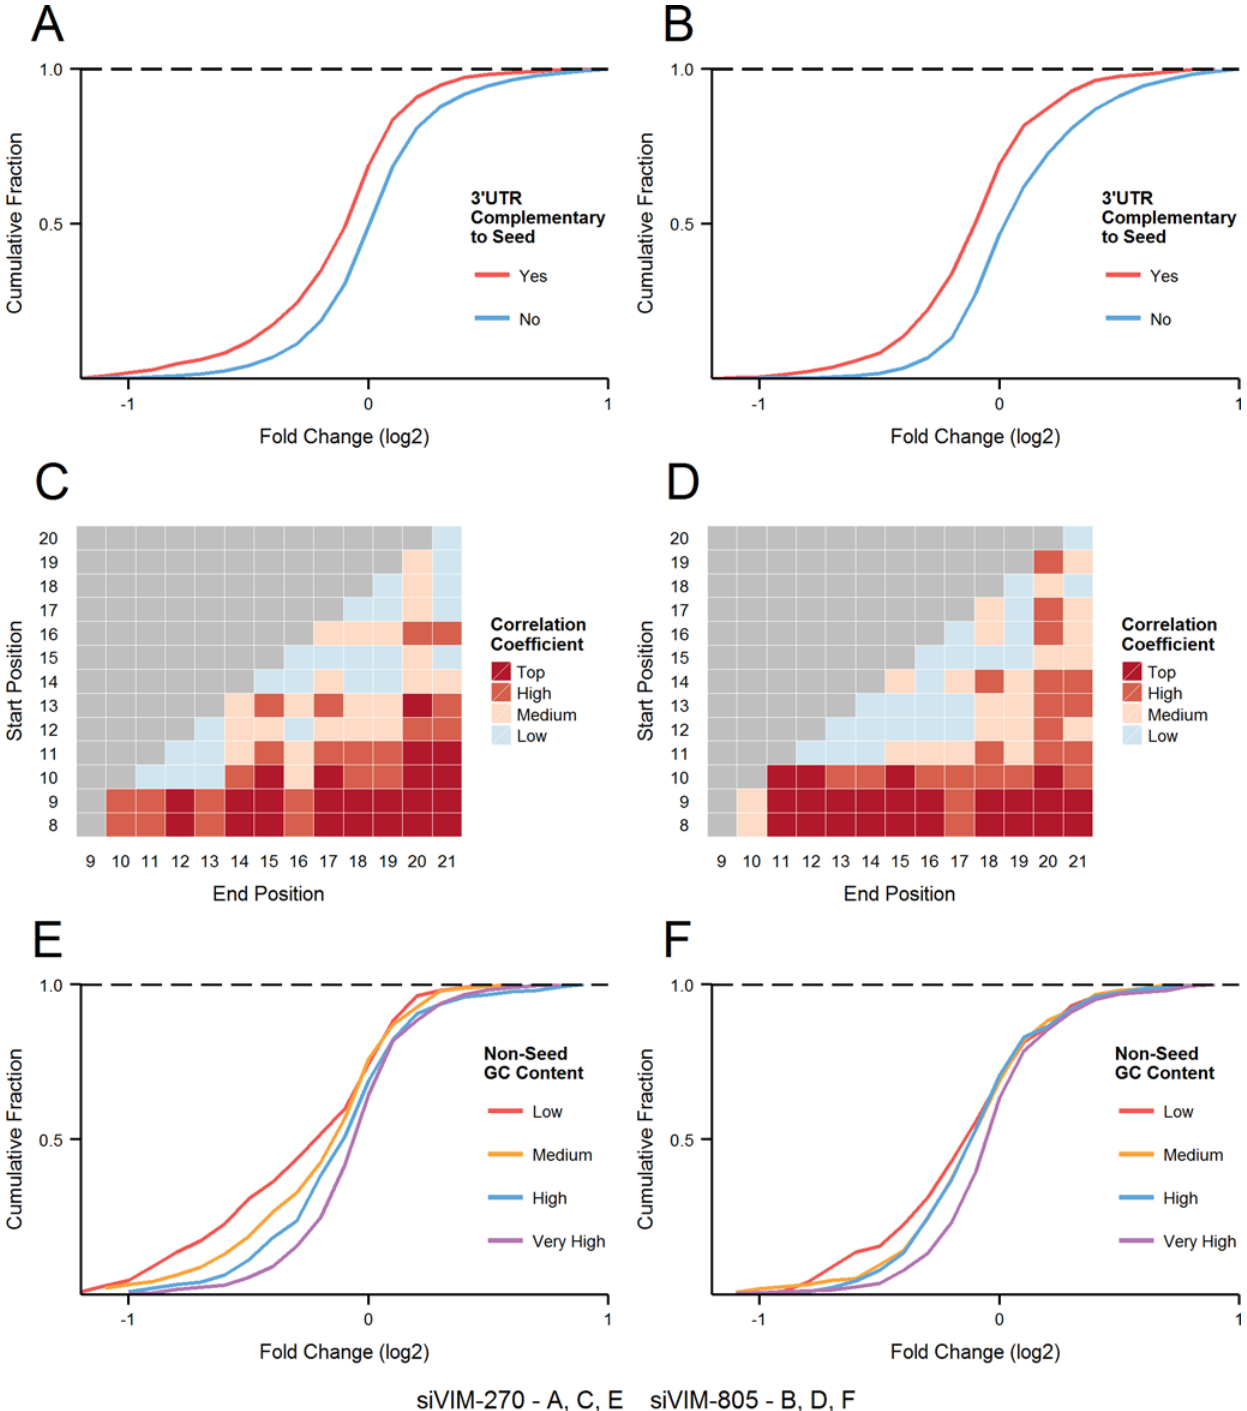
Fig 3. Seed and non-seed region-dependent off-target effect analyses for siVIM-270 and siVIM-805. (A, B) Expression profiles of off-target genes with 3 ’ UTR sequences that perfectly match the corresponding siRNA seed region (i.e. off-targets) were compared to genes without such sequence. (C, D) The correlation between GC content in all the subsections within mRNA targets of siRNA non-seed region (8 – 21) and fold change of off-target effect was calculated in a similar manner to that shown in Fig 2. The correlation coefficient was grouped using quantiles as boundary values and target position corresponds to the numbering shown in Fig 1. GC contents in the non-seed regions at positions 8 – 15 showed the highest correlation with off-target effect (Fig 3C; siVIM-270, r = 0.22, p-value = 1.13E-12, Fig 3D; siVIM-805, r = 0.15, p-value = 1.57E-05). (E, F) Off-target transcripts for siVIM-270 and siVIM-805 were divided into four groups defined by the number of GC nucleotides in their non-seed regions (positions 8 – 15). Quantiles were used as the boundary values for